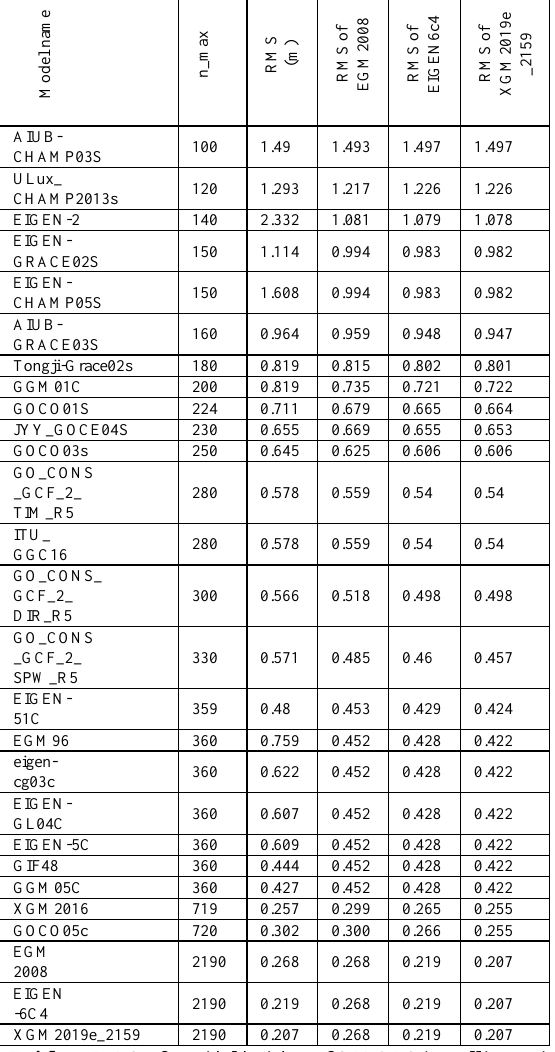
Figure 1 . Definition of geoid height with respect to reference ellipsoid within the earth's